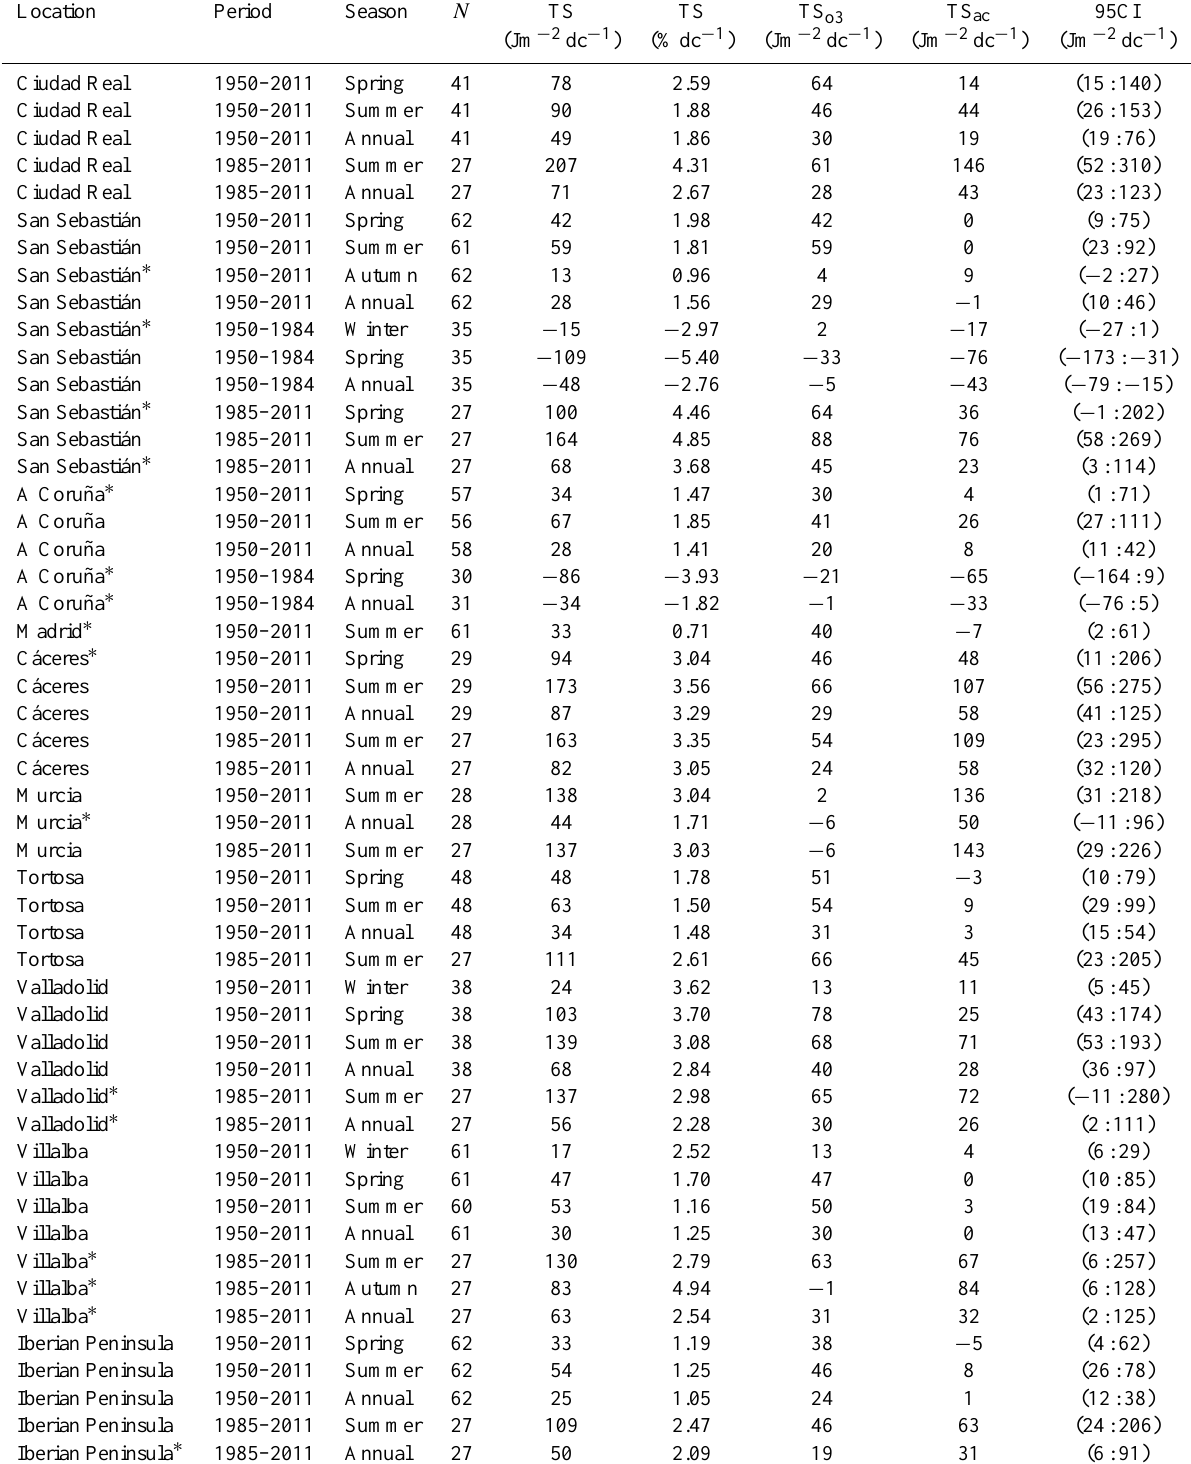
Table 3. Statistically significant UVER irradiation trends with a confidence of 99% (95% marked with an asterisk) and their 95% confidence interval, at different seasons and locations for the 1950–2011, 1950–1984, and 1985–2011 periods. TS o3 and TS ac are also included. N is the number of data